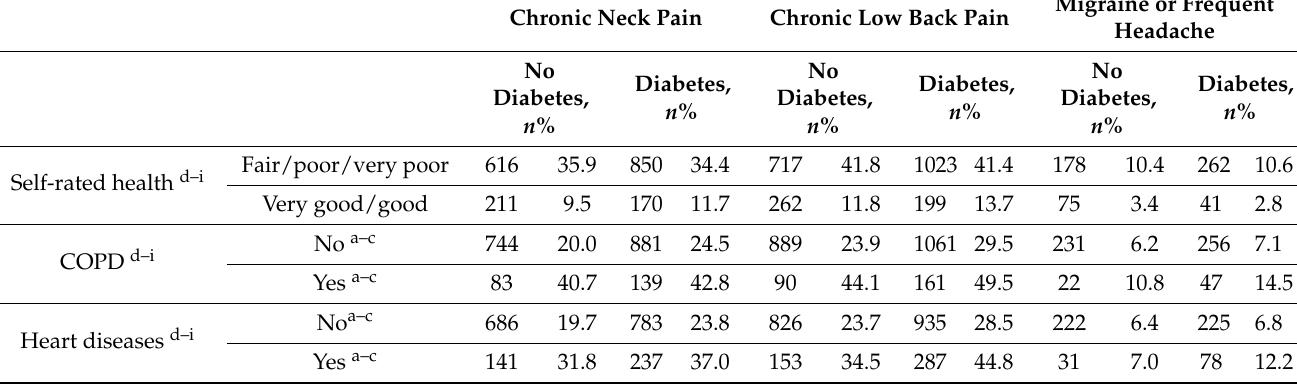
Table 3. Prevalence of chronic neck pain, chronic low back pain, and migraine or frequent headache among subjects with diabetes and sex–age-matched subjects without diabetes according to clinical variables and